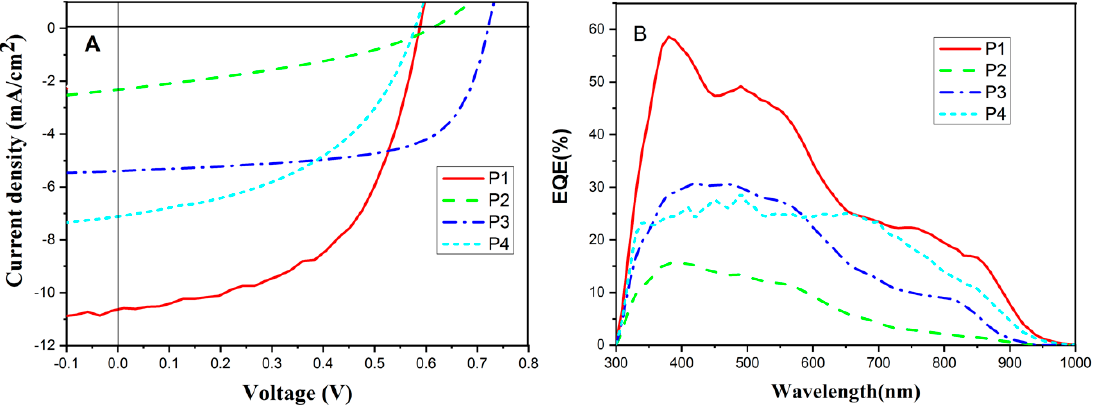
Figure 4. Current density-voltage ( J-V ) characteristics ( A ) and External quantum efficiencies (EQE) spectra ( B ) of polymer solar cells (PSCs) based the devices with the conventional architecture of ITO/PEDOT:PSS/polymer:PC 71 BM/PFN/Al.